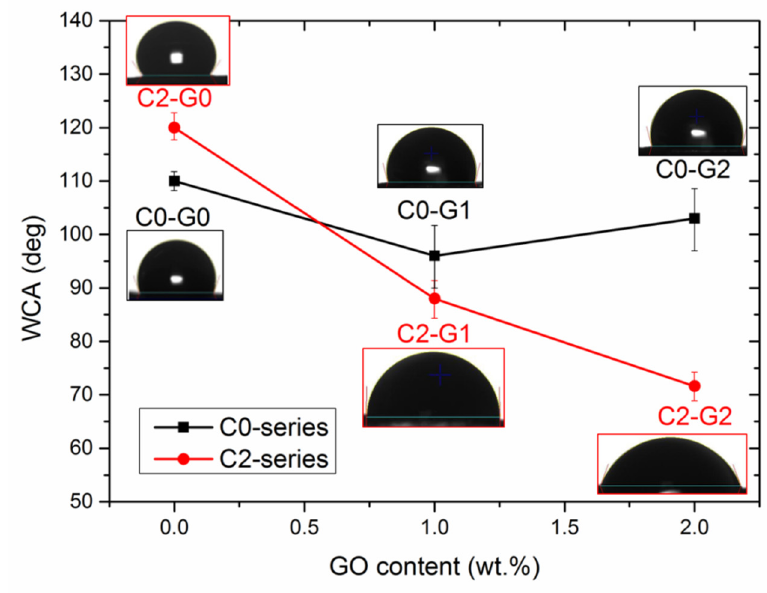
Figure 5. The hydrophilicity of the samples, as evaluated by WCA